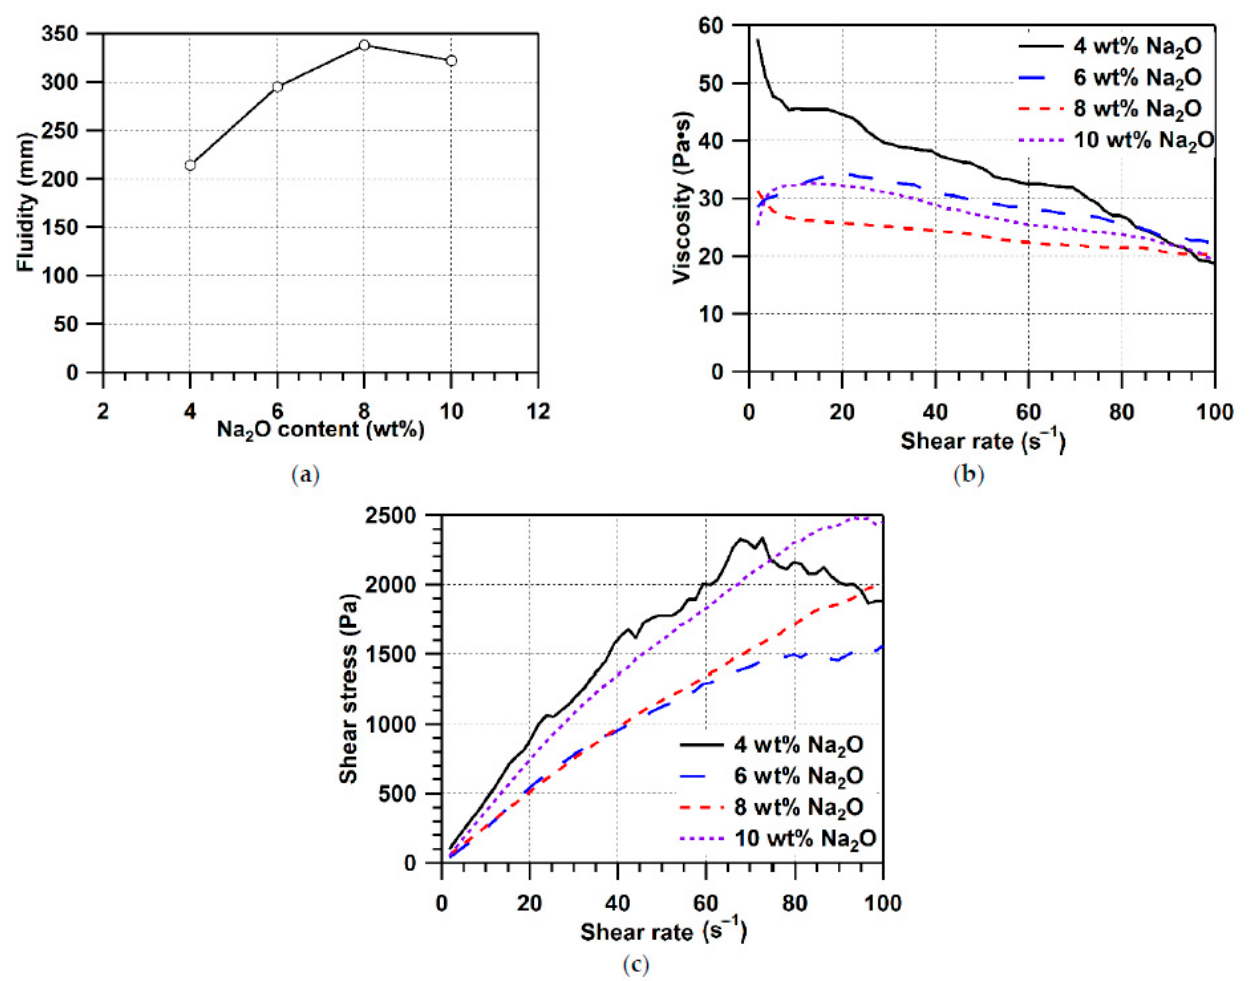
Figure 10. The relationship between the amount of water glass (as Na 2 O content) and ( a ) fluidity, ( b ) apparent viscosity and ( c ) shear stress of fresh